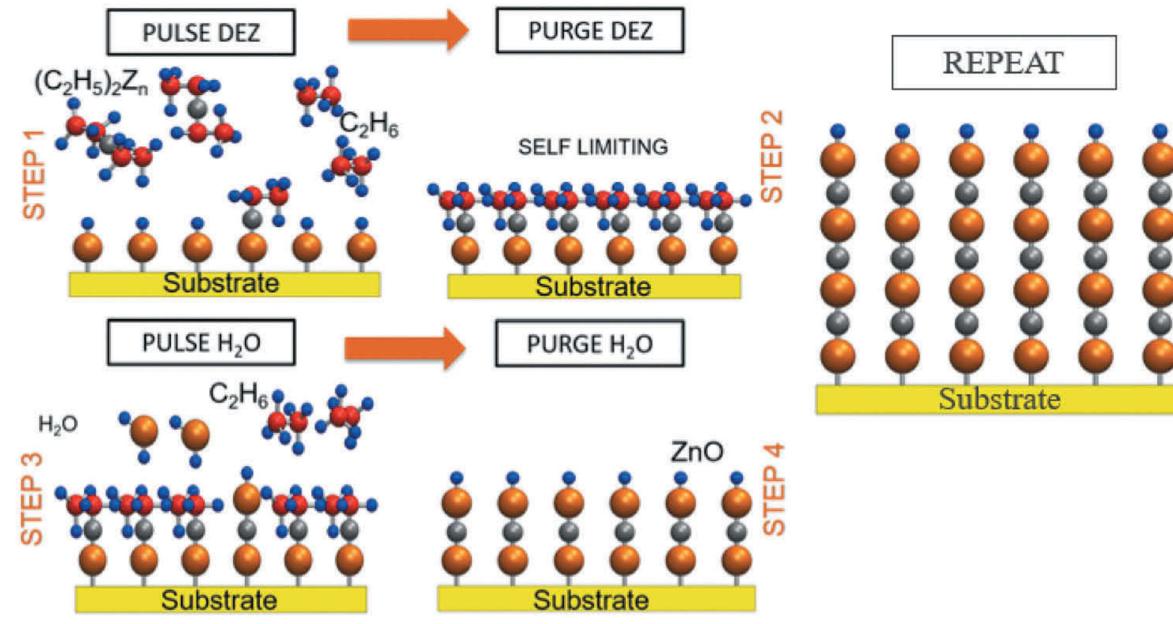
Figure 1: Demonstration of zinc oxide ALD using ( C 2 H 5 ) 2 Zn and H 2 O precursors [ 2 ]